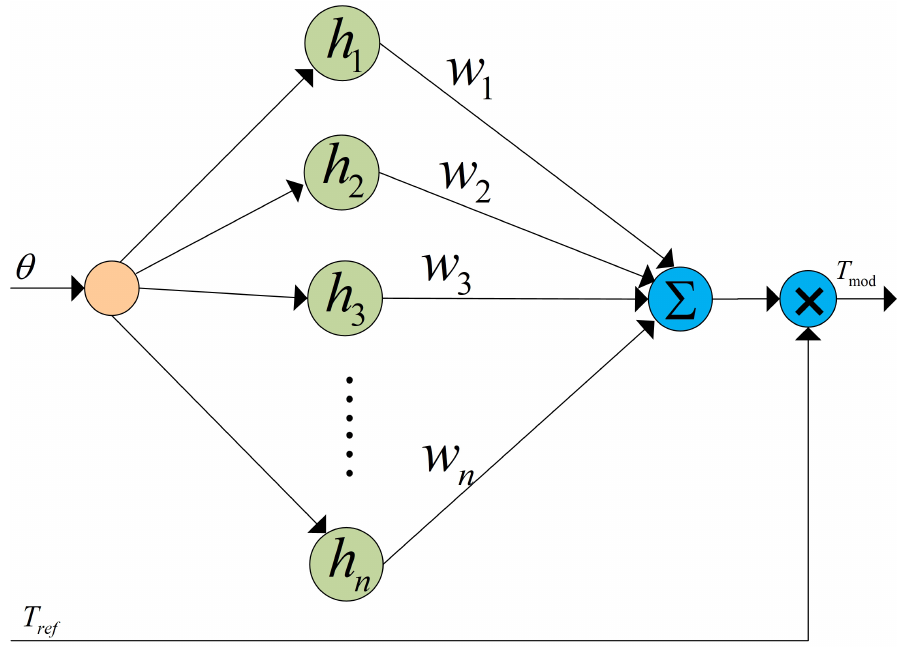
Figure 7. RTNN internal